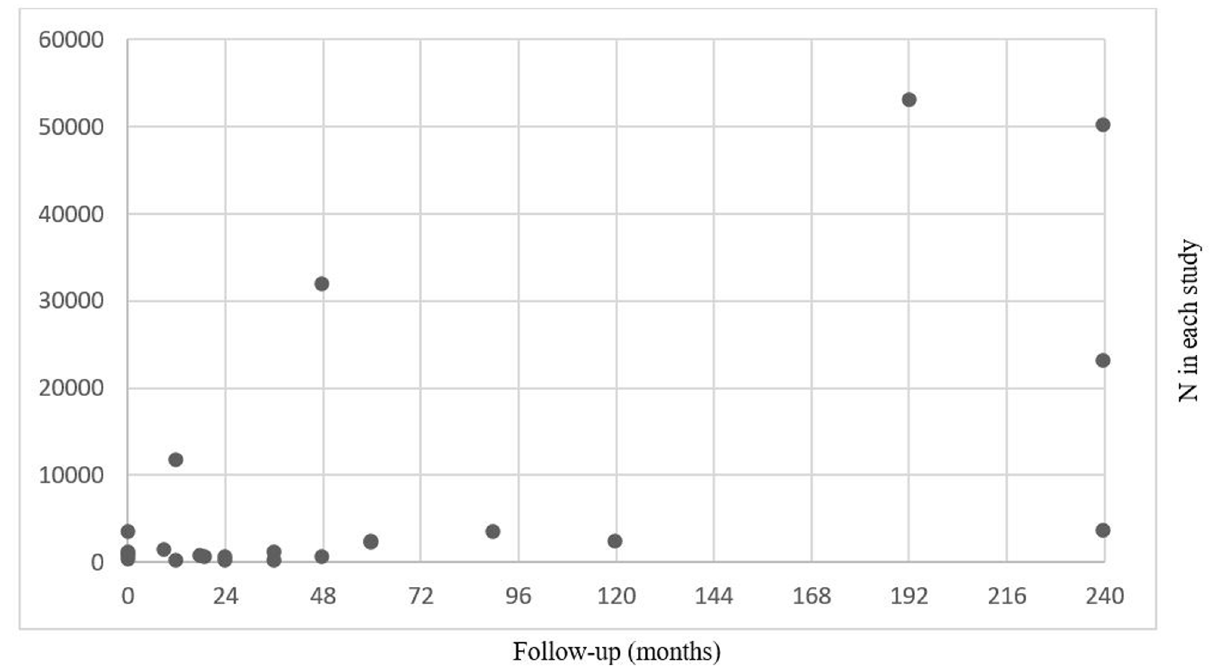
Fig 4. Number of participants and longest follow-up time a in cited observational studies (n = 24). Data from the reviews in Table 1 that presented characteristics on all included primary studies. All studies presented results on diet soda consumption with unspecified type of intense sweetener used. a For studies analysed in multiple primary publications, the longest follow-up is